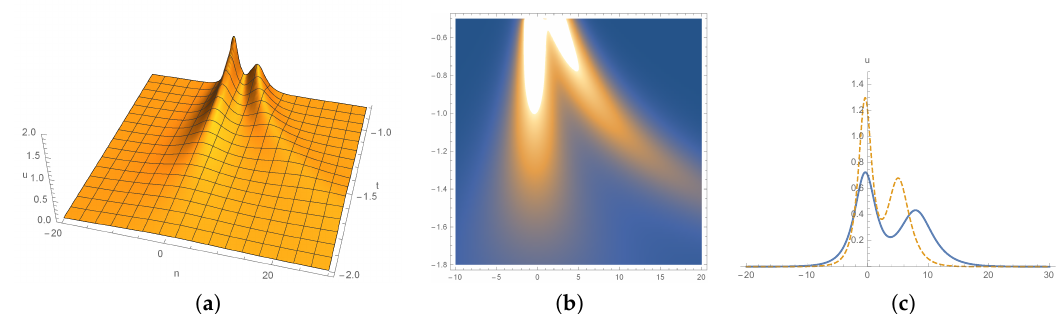
Figure 5. u n given by (38) with (cid:101) = − 1 for c 1 = 1, c 2 = 0.4 and α 1 = α 2 = 1. ( a ) shape and motion; ( b ) a contour plot of ( a ) with range n ∈ [ − 10,20 ] and t ∈ [ − 1.8, − 0.5 ] ; ( c ) waves in blue (solid line) and yellow (dotted line) stand for plot ( a ) at t = − 0.8 and t = − 1.2,